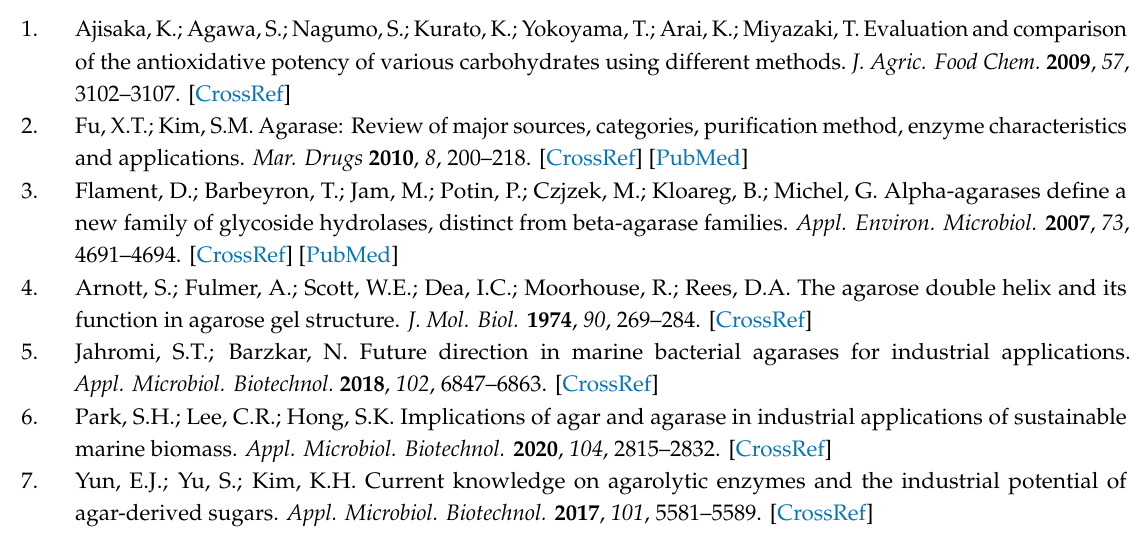
Table S1: Primers used in this